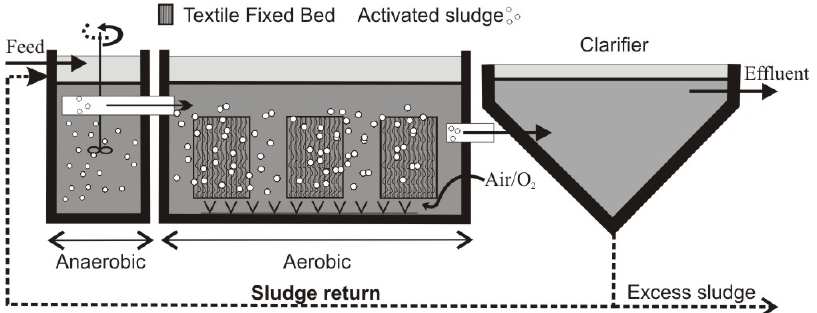
Figure 2. Simplified technological diagram of the WWTP in Mirków with the installed modules (textile fixed beds).